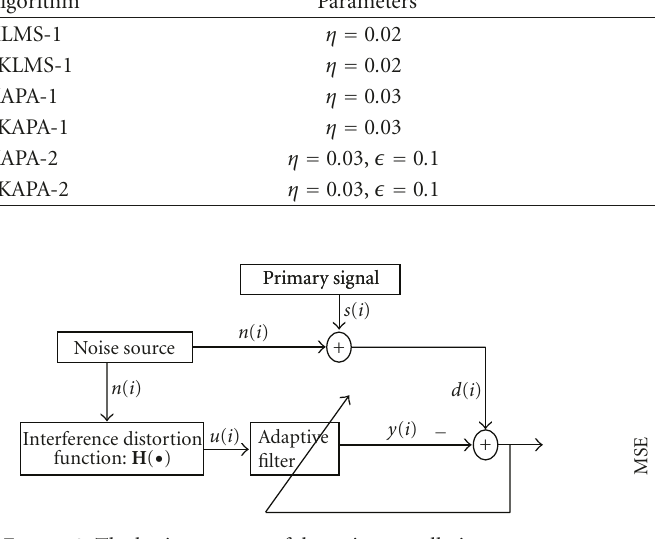
Figure 3: The basic structure of the noise cancellation system.